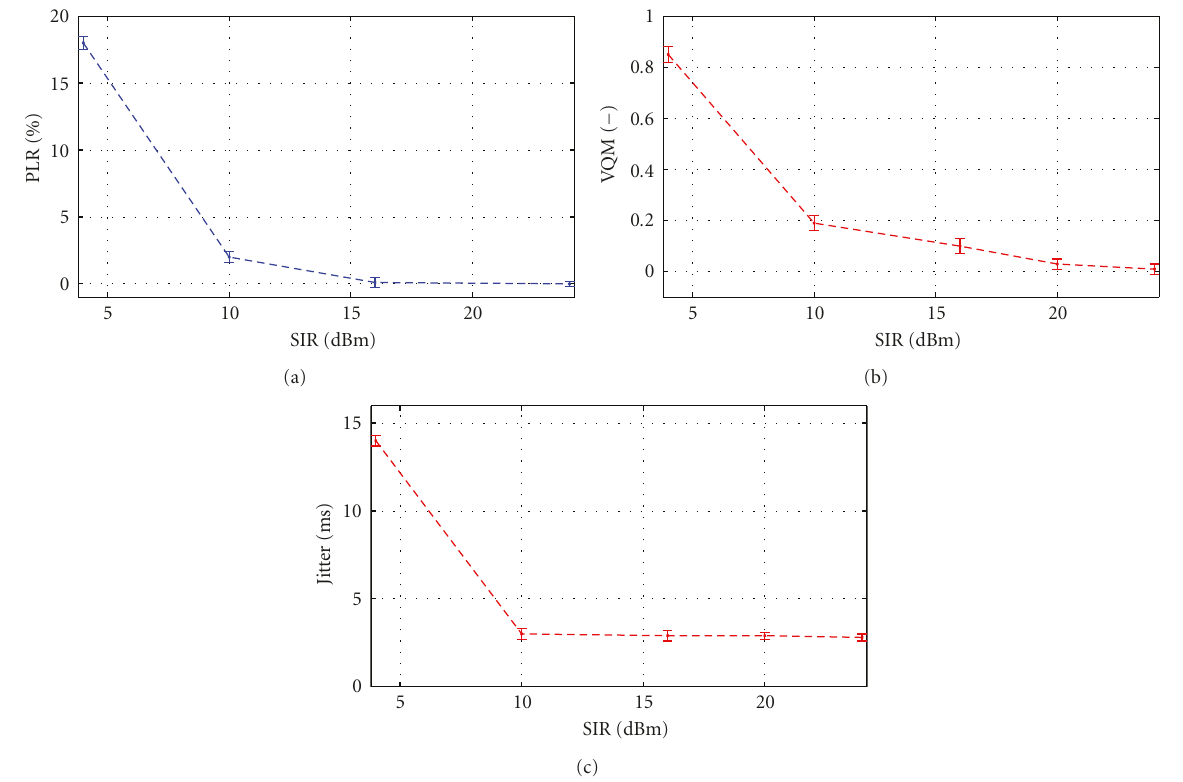
Figure 3: Bluetooth interference and multicast video streaming: PLR (a), VQM (b), and jitter (c) versus SIR.